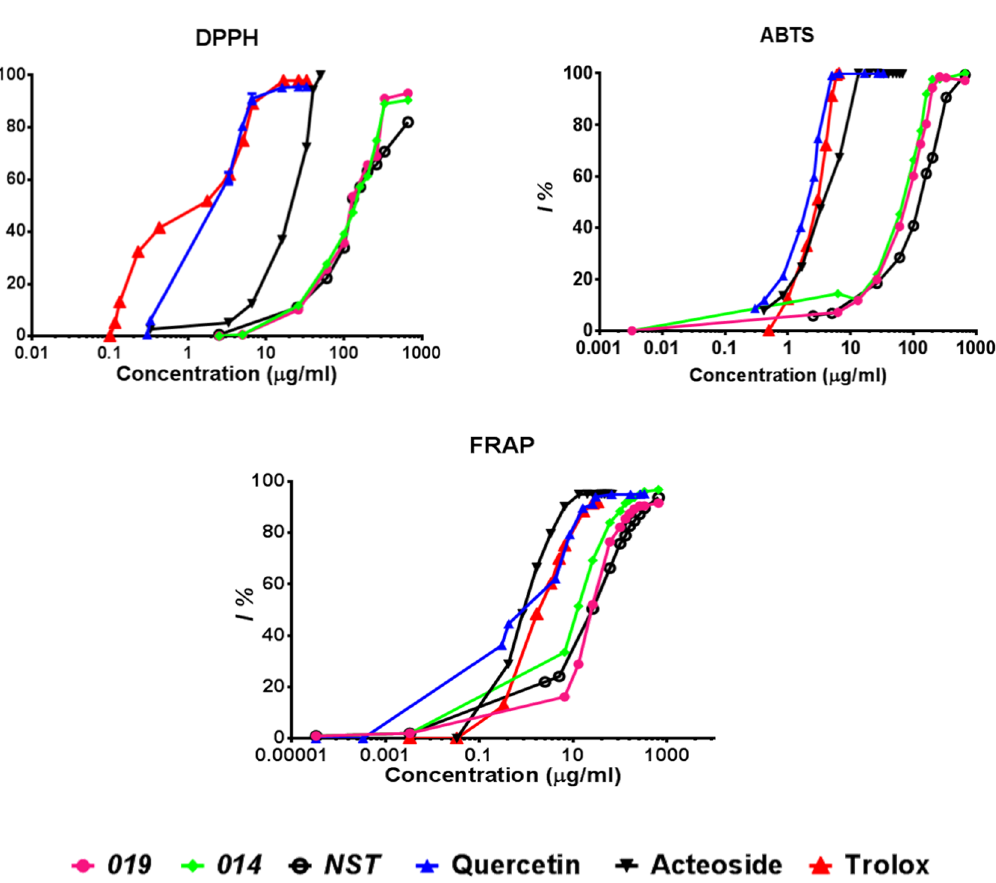
Figure 4. Antioxidant activity of spagyric tinctures 019 and 014, the NST, quercetin, acteoside, and Trolox as a positive control, as determined by DPPH, ABTS, and FRAP methods.